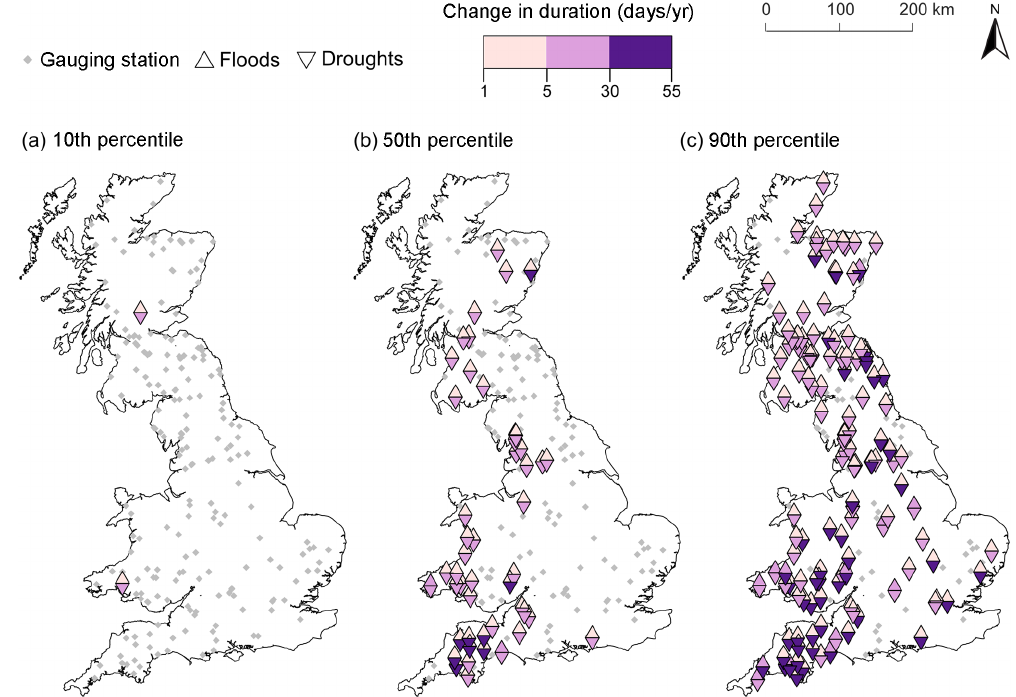
Figure 7. Changes in duration of the hydro-hazards for the hot-spots in Great Britain for the (a) 10th, (b) 50th, and (c) 90th percentiles.